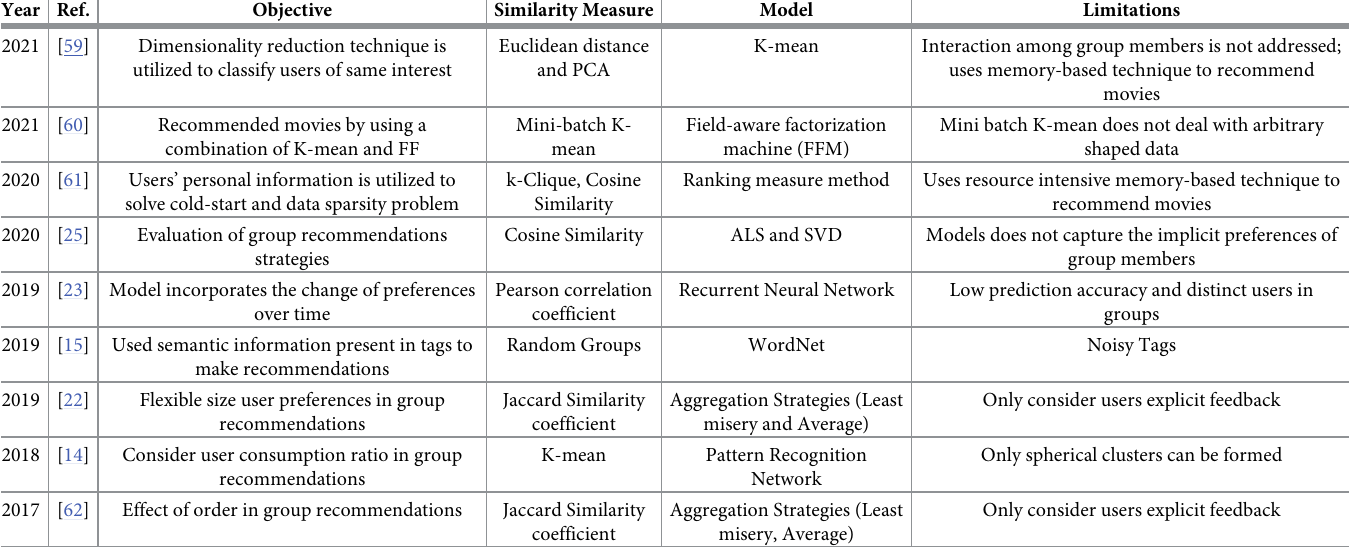
Table 1. Comparisons of state of the art schemes. Year Ref.